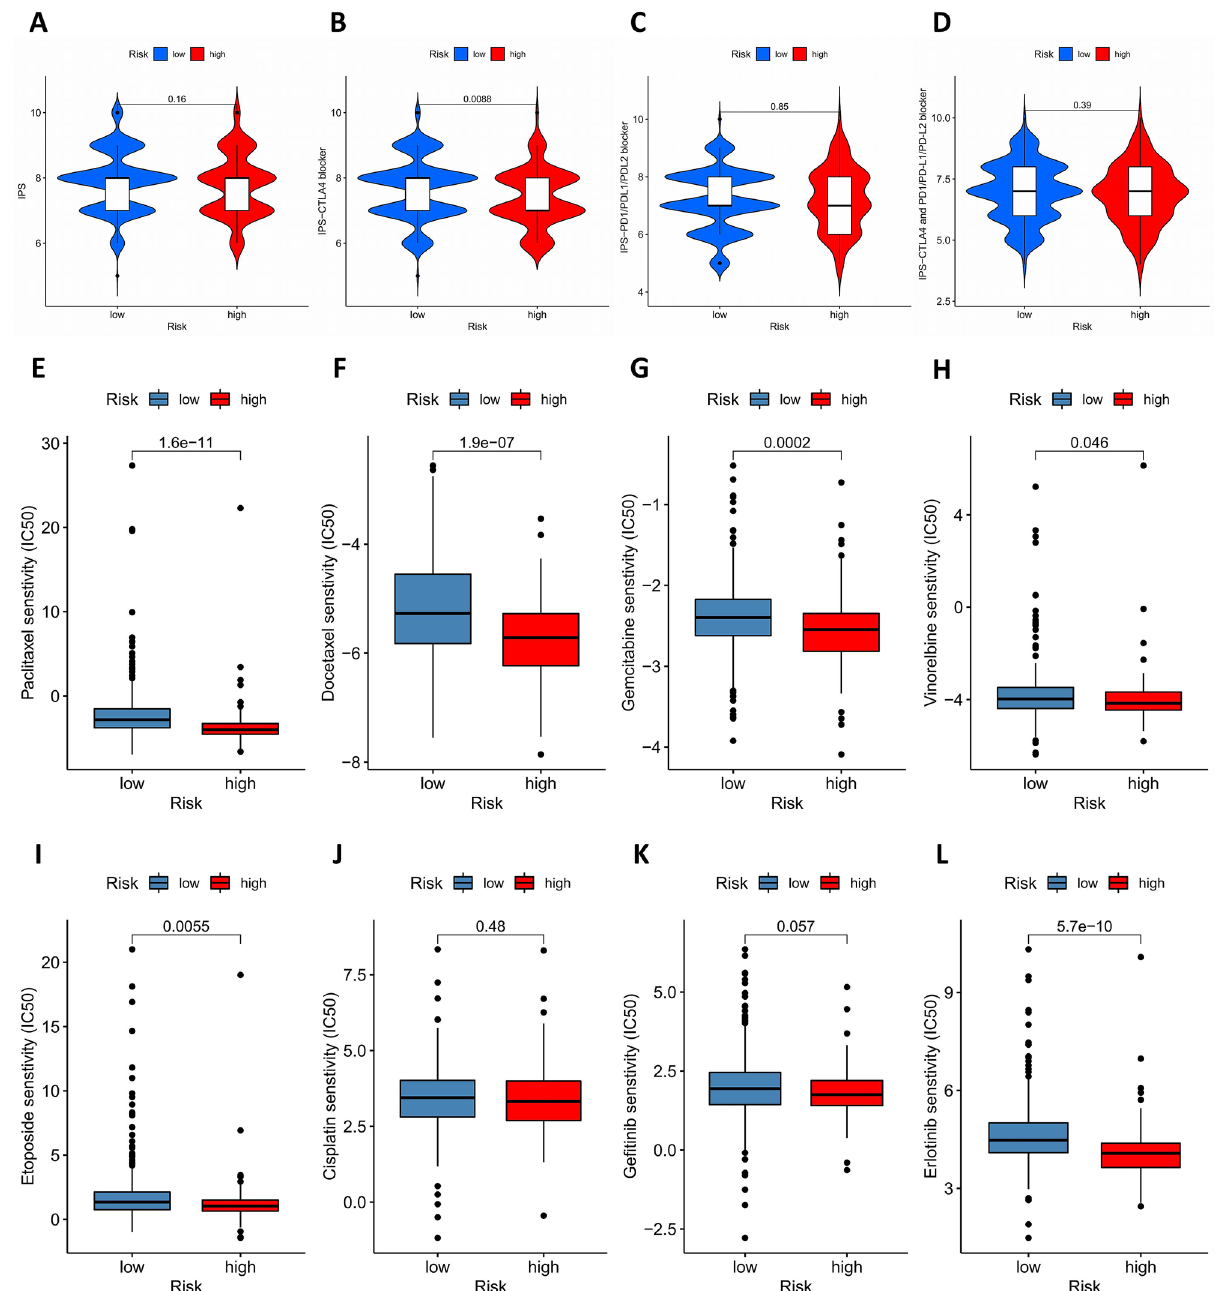
Figure 5. The Relationship between risk model and sensitivity of anti-tumor drugs. ( A-D ) The association between IPS and the immune-related risk signature of LUAD patients. ( E-L ) The difference of IC50 of anti- tumor drugs, including paclitaxel ( E ), docetaxel ( F ), gemcitabine ( G ), vinorelbine ( H ), etoposide ( I ), cisplatin ( J ), gefitinib ( K ), and erlotinib ( L ), between the high-risk and low-risk subgroups. IPS, Immunophenoscore; LUAD, lung adenocarcinoma; IC50, the half inhibitory